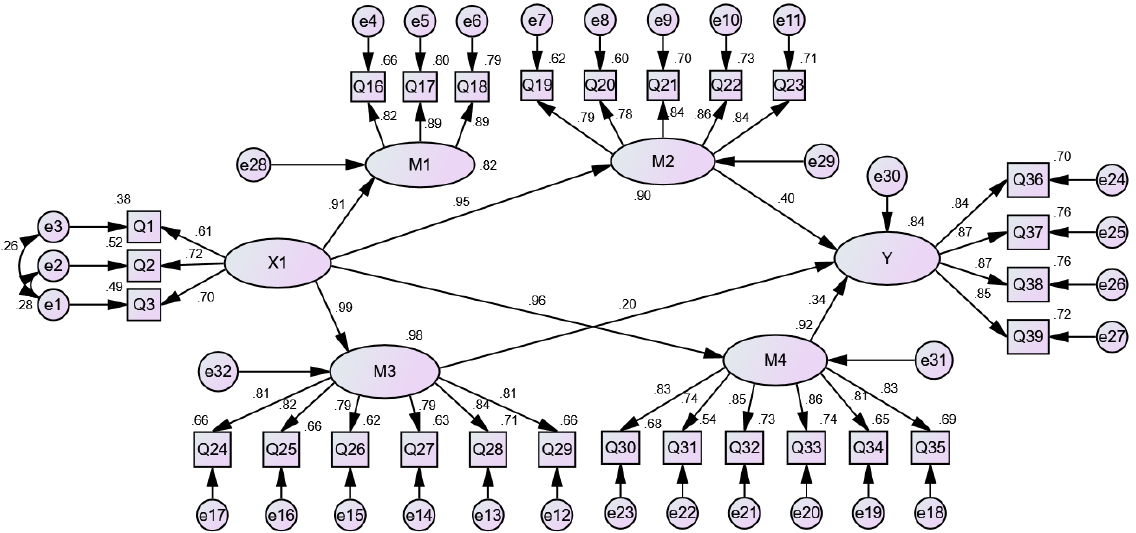
Figure 2. A revised model of the influence mechanism of career development on the happiness of urban young returnees.